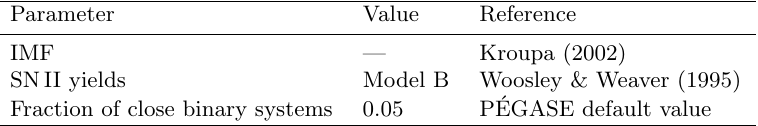
Table 1. The parameter sources for the P´EGASE software. Parameter Value Reference IMF — Kroupa (2002) SN II yields Model B Woosley & Weaver (1995) Fraction of close binary systems 0.05 P´EGASE default